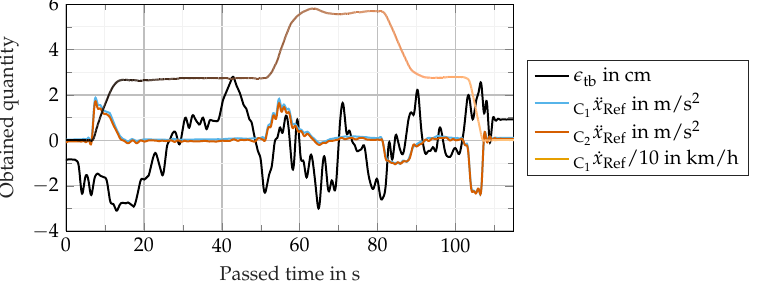
Figure 9. Exemplary measurement reading from one out of five trials. The distance error in cm, longitudinal acceleration, and velocity of the front vehicle are shown. Note that velocity is scaled for better readability. The color gradient with the velocity indicates the running